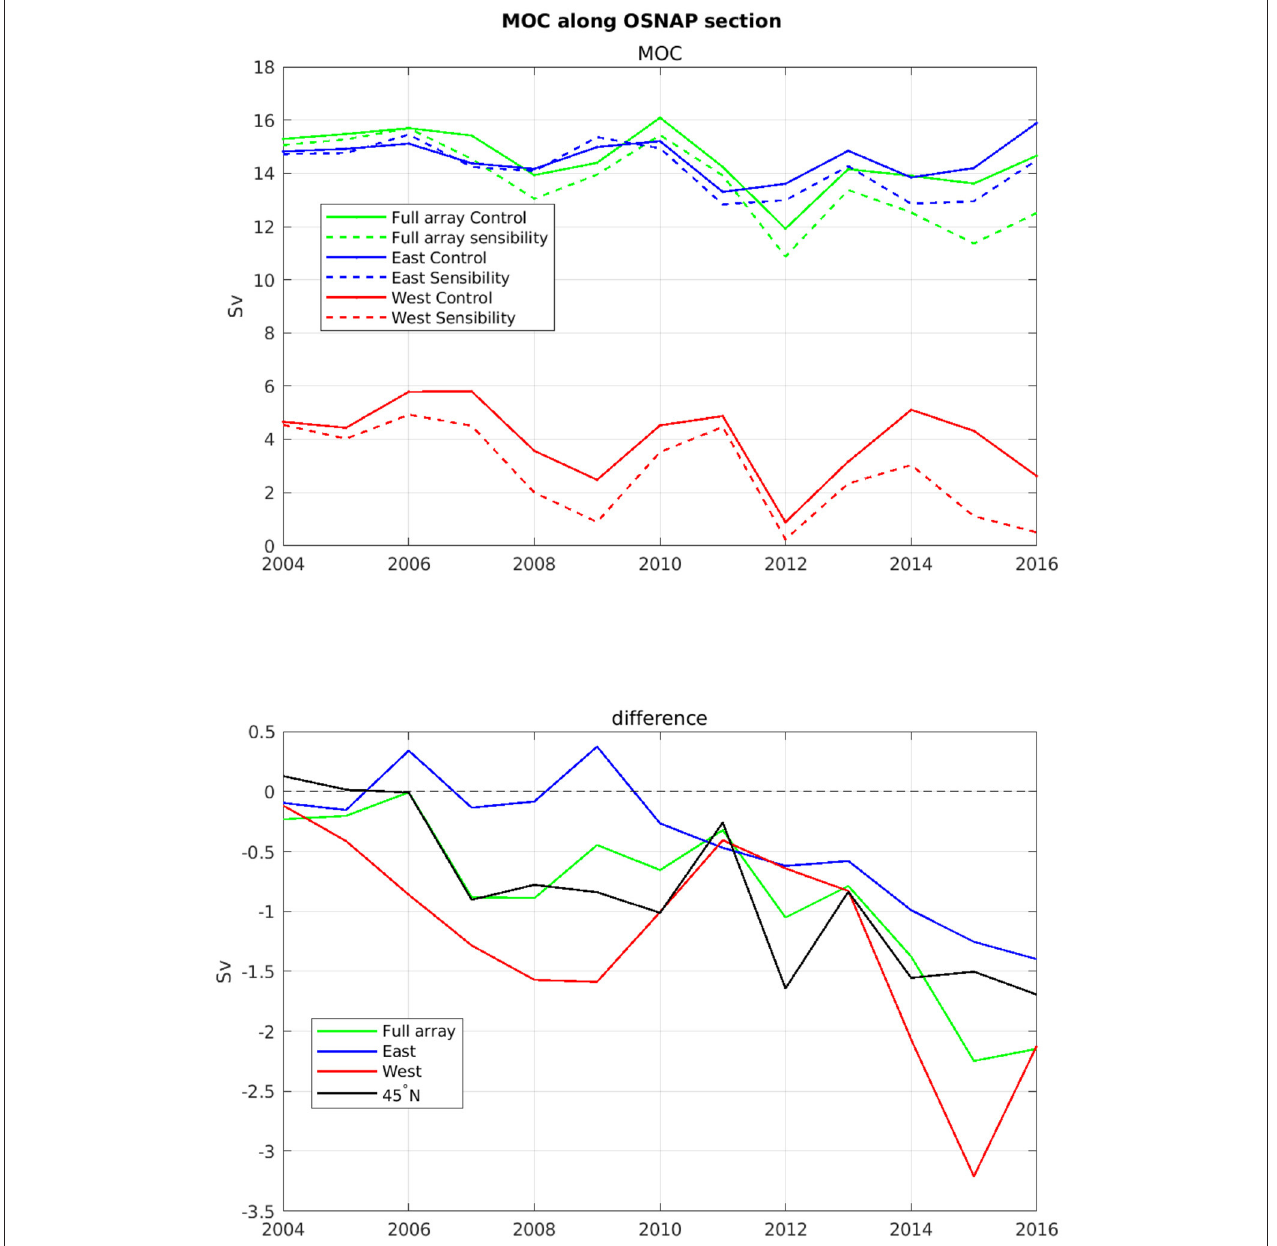
FIGURE 9 | Time evolution of AMOC indices (in Sv) computed in density space in the HR simulations (maximum of the annual mean stream function). Top is showing the annual mean values in the different experiments (continuous line for control, dashed line for melting simulations) in red for OSNAP west, in blue for OSNAP east and in green for the full OSNAP array. The bottom panel is showing the differences between the two (melting minus control) simulations with the same color code, also with in black, the MOC index in density space computed at 45 ◦